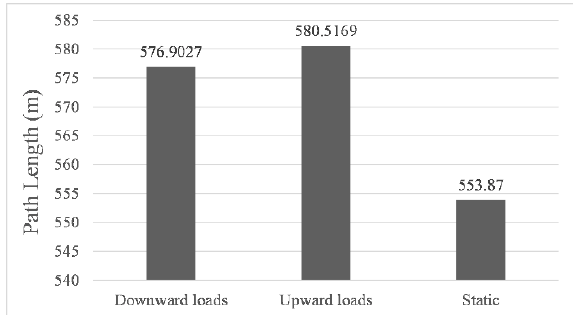
Figure 7. Path length for simulated navigations.